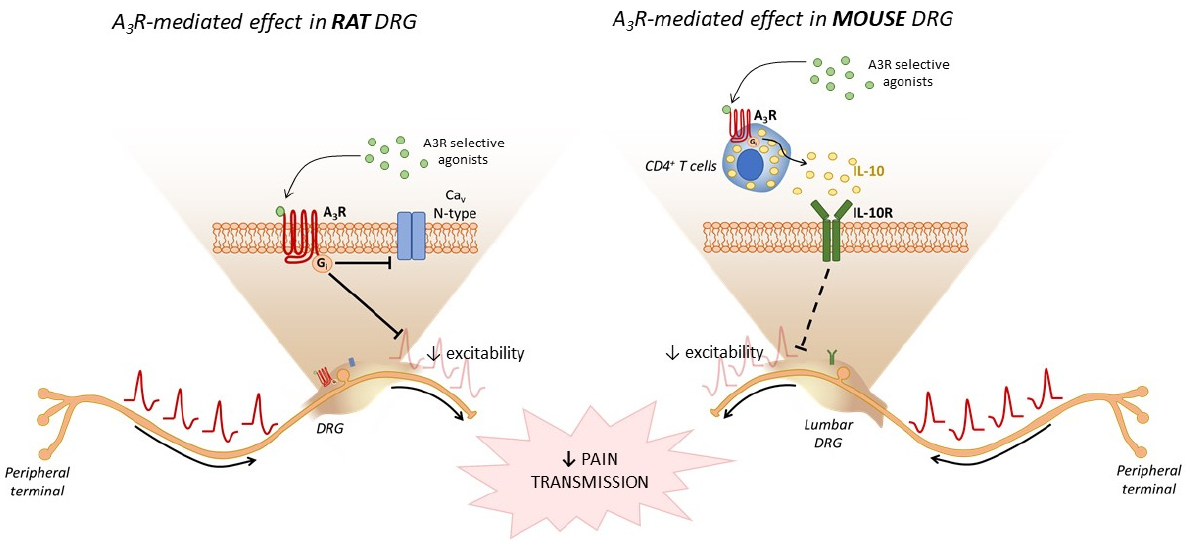
Figure 3. Adenosine A 3 receptors and pain control. A 3 receptors (A 3 Rs) are expressed on rat DRG neurons, and their activation by the selective agonist MRS5980 decreases action potential (AP) neuronal firing and inhibits N-type voltage-gated calcium channels [110]. A 3 Rs expressed on CD4 + T cells, but not on mouse DRG neurons, promote interleukin-10 (IL-10) release that, by activating IL-10 receptors (IL-10R) on DRG neurons, reduces neuronal excitability by inhibiting AP firing [117].